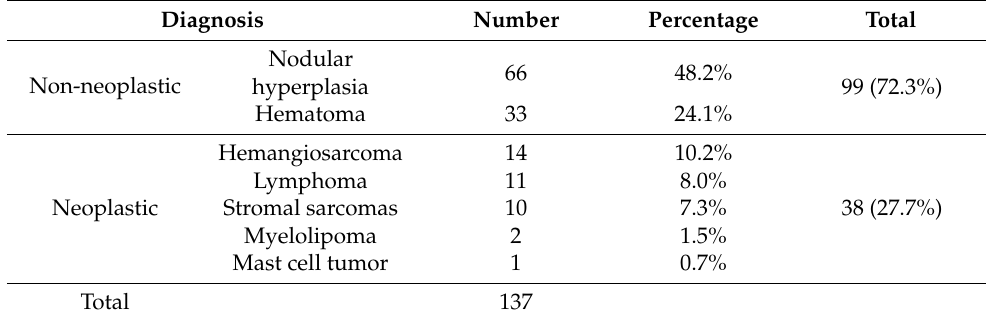
Table 2. Histopathological diagnoses of 137 canine splenic tissues.